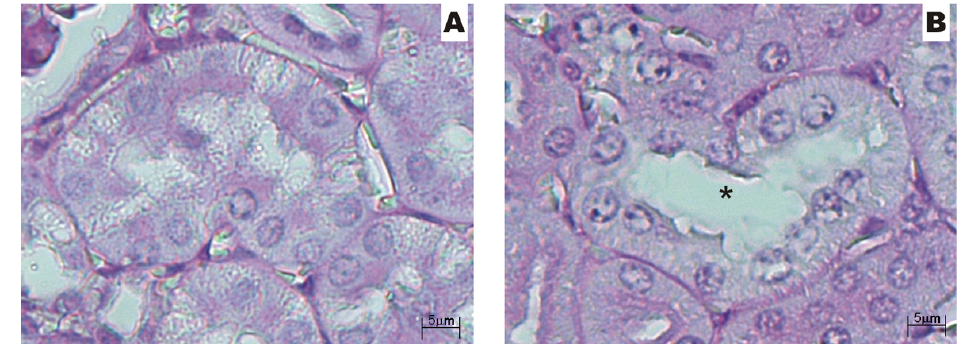
Figure 1. Histopathological findings obtained by light microscopy for normal and lipopolysaccharide (LPS)-injured kidney (100 mg/kg). A , Tubules from normal mice; B , tubules from LPS-injured kidney - tubular dilatation (asterisk). Staining: hematoxylin-eosin; original magnification: